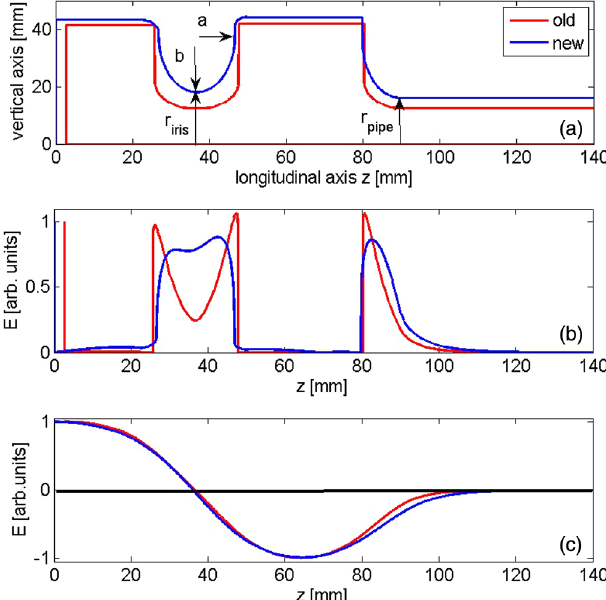
FIG. 1. (a) 2D profile (compared with the previous gun profile); (b) surface electric field normalized to the peak cathode field; (c) longitudinal electric field on axis.